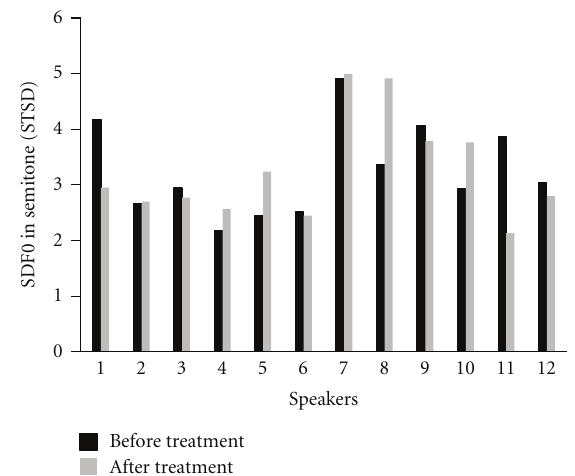
Figure 1: Standard deviation of fundamental frequency (SDF0), in semitones, for individual